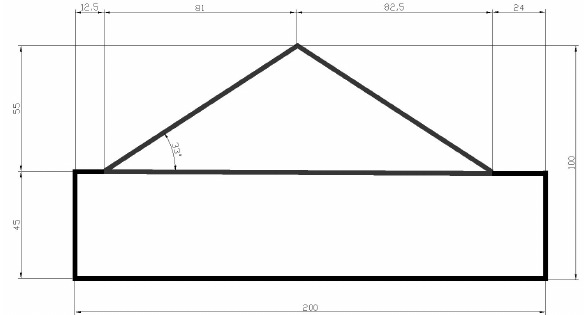
Figure 2b Geometry adopted for the examination of a complete model of the flood